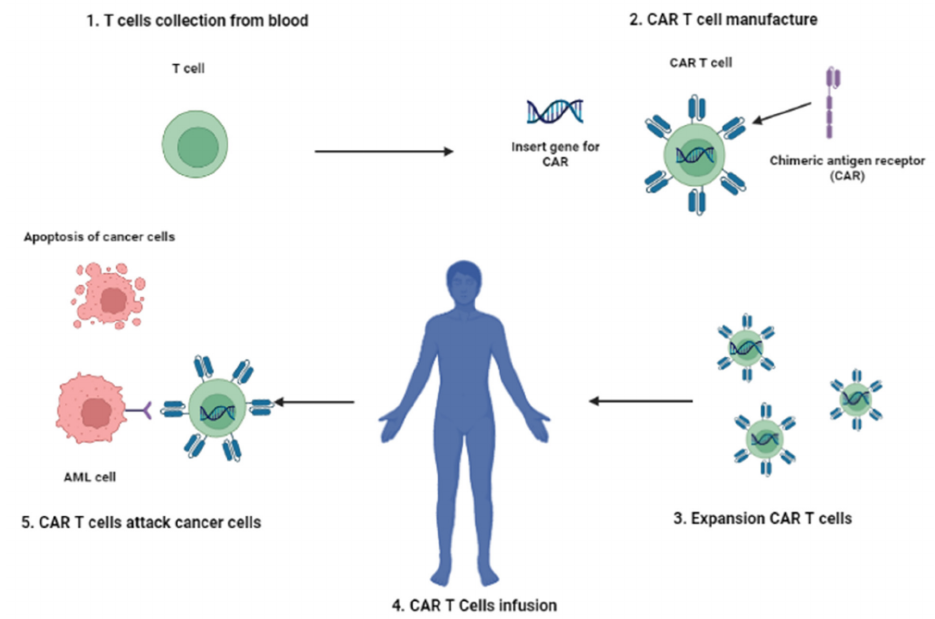
Figure 2. CAR-T immunotherapy. ( 1 ) Patient’s T cells are collected by leukapheresis. ( 2 ) A viral vector delivers a gene encoding a CAR into the T cells. ( 3 ) Expansion of CAR-expressing T cells. ( 4 )The CAR-T cells are infused into the patient’s blood ( 5 ). CAR-T cells attack cancer cells. The figure was created with